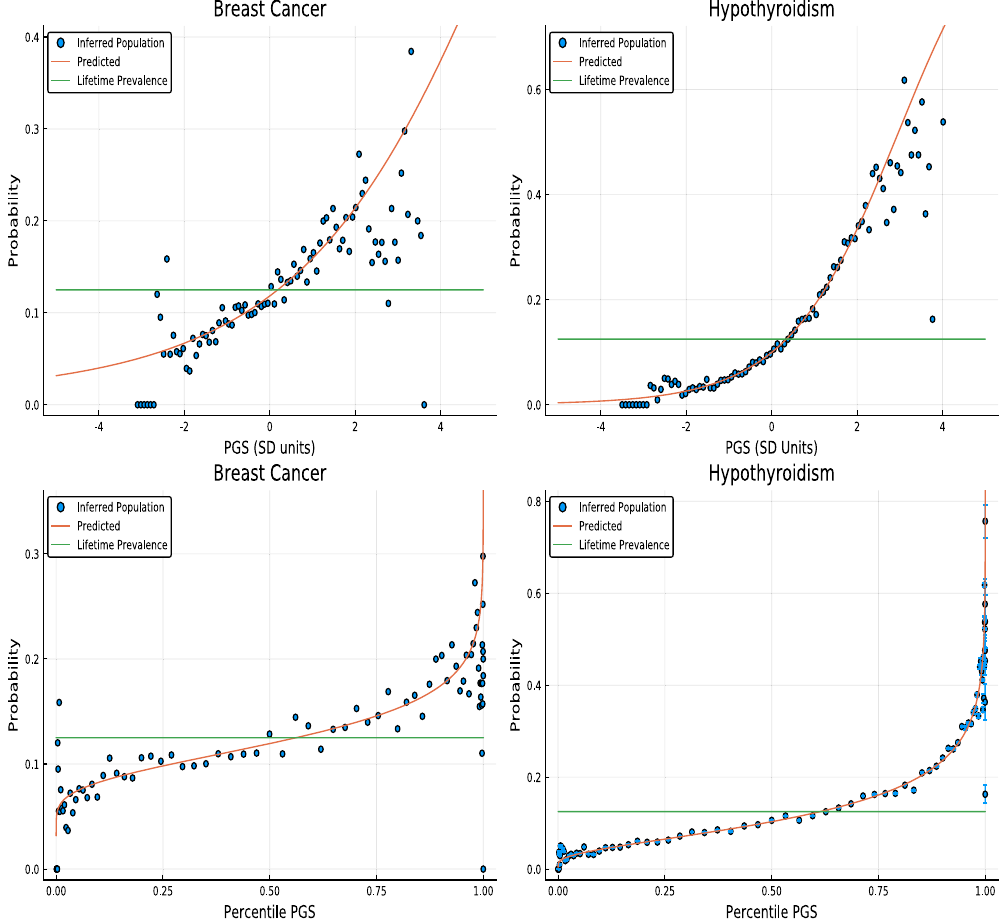
Figure 2. Probability of developing breast cancer or hypothyroidism given a specific polygenic score - shown in SD units and percentile. The lifetime population prevalence of both breast cancer and hypothyroidism are set to be 12%. Deviation from the red line, particularly at large and small PGS percentile, is likely an artifact of low statistics in these